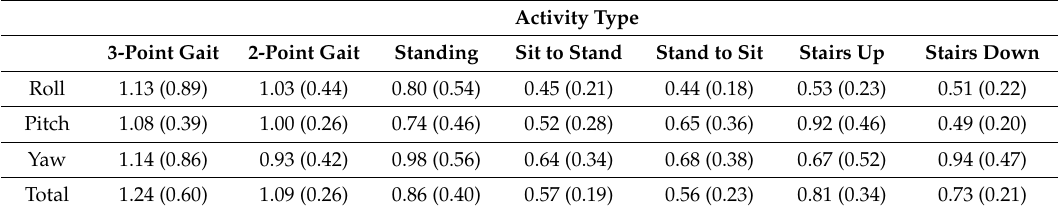
Table 5. Means (standard deviations) of the RMSEs in the roll, pitch, yaw and total cane orientations estimated by the Madgwick filter (unit: degrees).